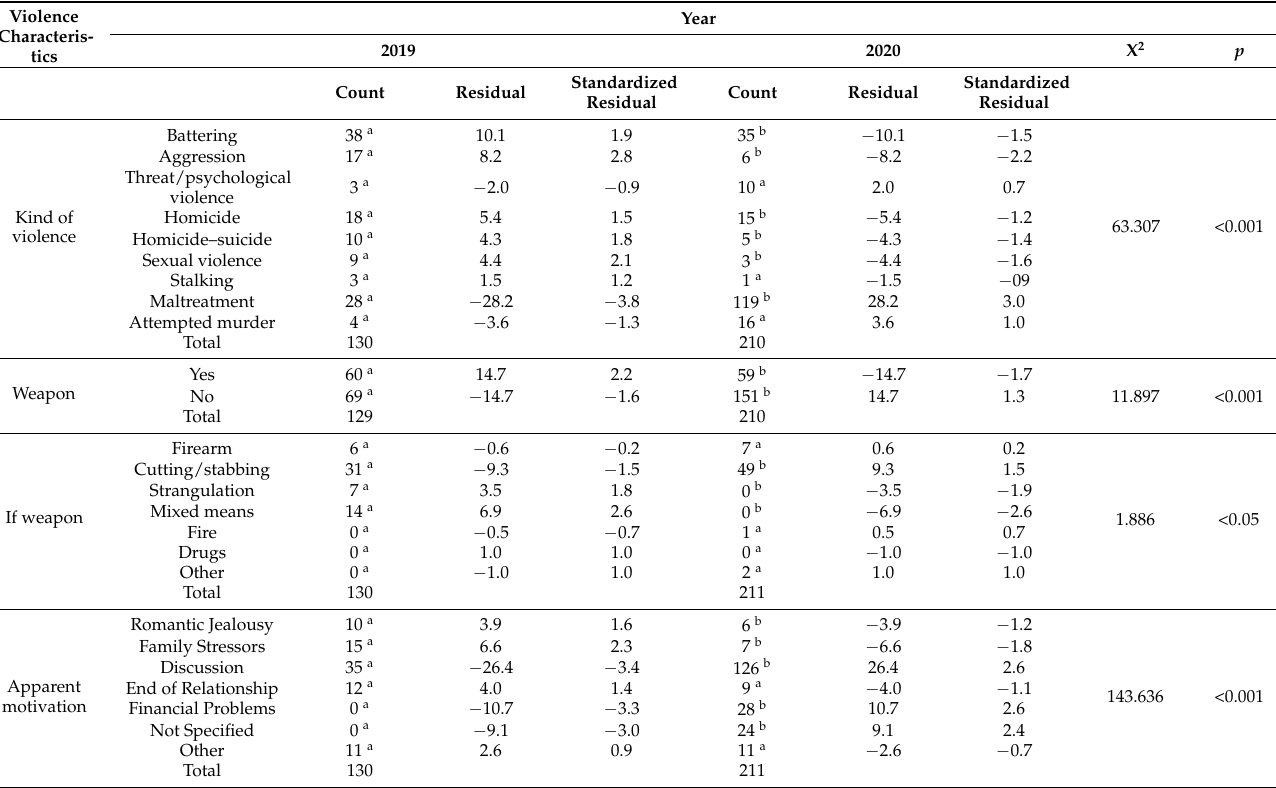
Table 4. The characteristics of the